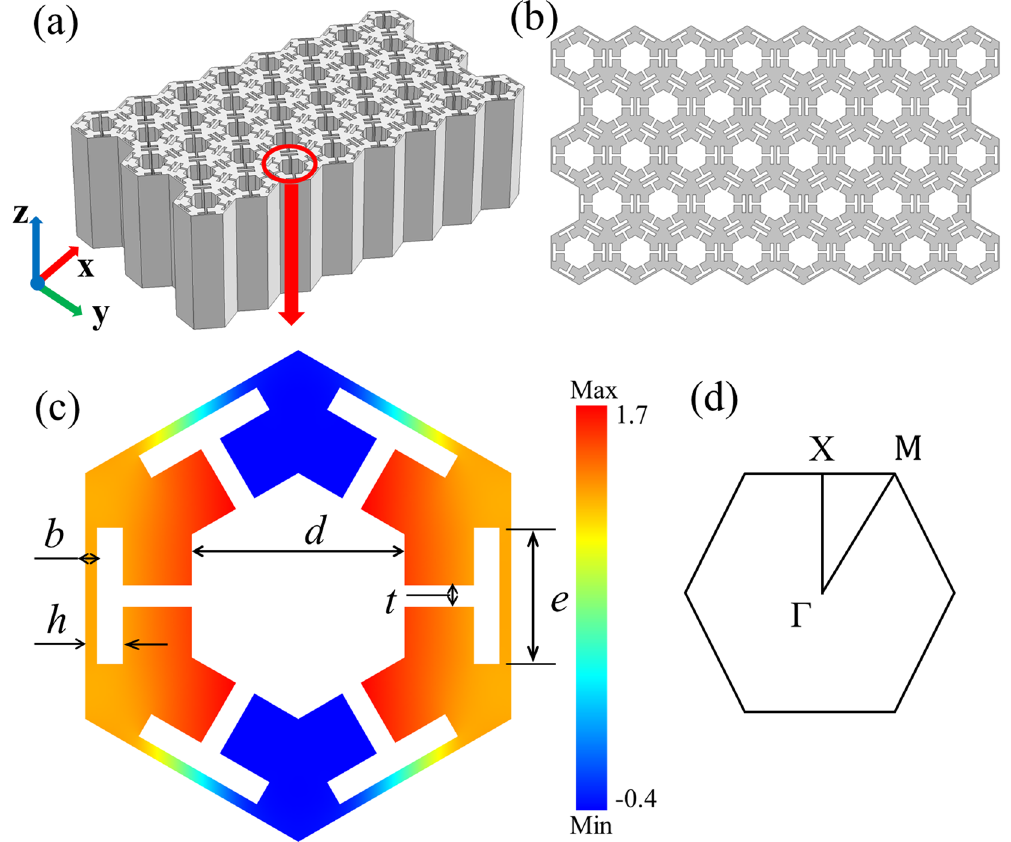
Figure 1. ( a ) The 3D view of the periodic structure; ( b ) the 2D topological structure of the slab; ( c ) the unit-cell of the 2D PC with the color showing the vibration mode of the first longitudinal band along the Γ X direction; and ( d ) the corresponding irreducible Brillouin